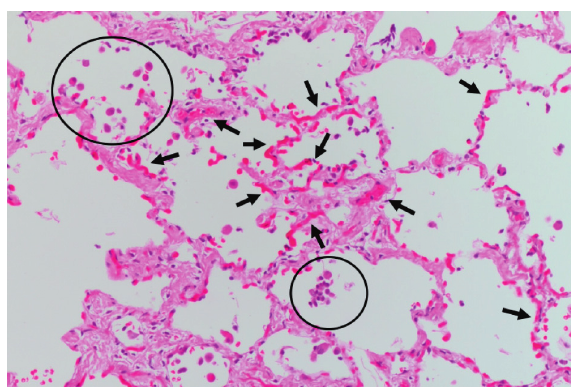
Figure 3: Histological findings of nonspecific interstitial pneu- monia with a higher hemosiderin score. Aggregation of pigmented macrophages in alveolar spaces (circles) and capillary multiplica- tion (arrow heads) was shown (Hematoxylin–Eosin